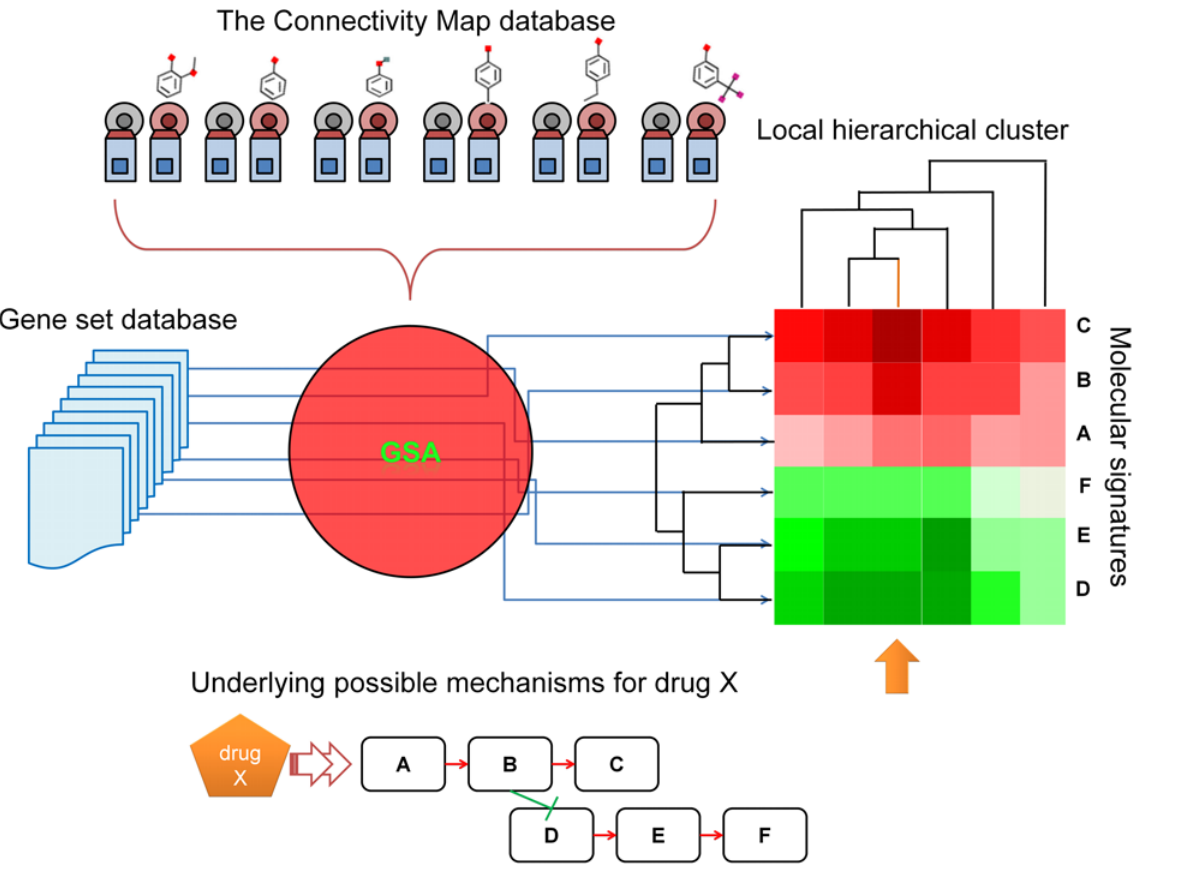
Fig 1. The GSLHC